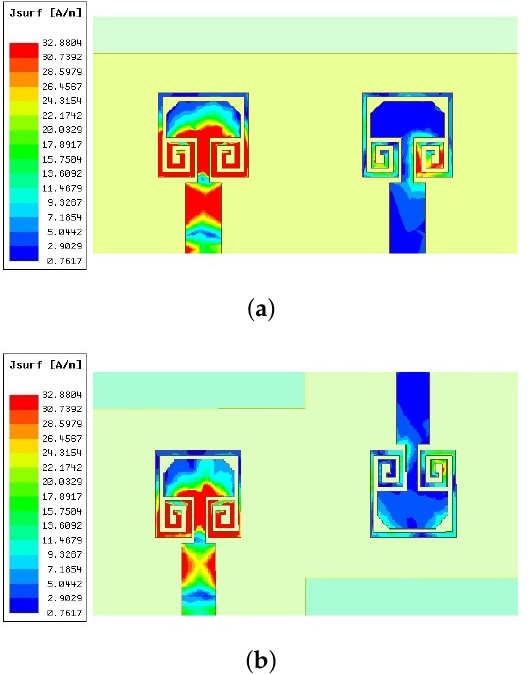
Figure 12. Surface current distribution of MIMO-1 and 2 configurations ( a ) MIMO-1 ( b ) MIMO-2.